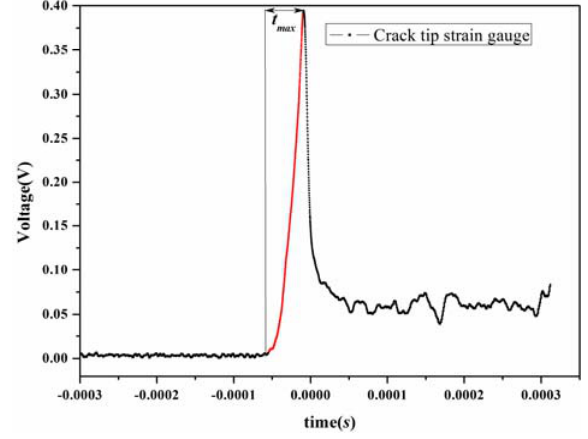
Figure 4. Maximum time of the crack tip strain gauge signal.